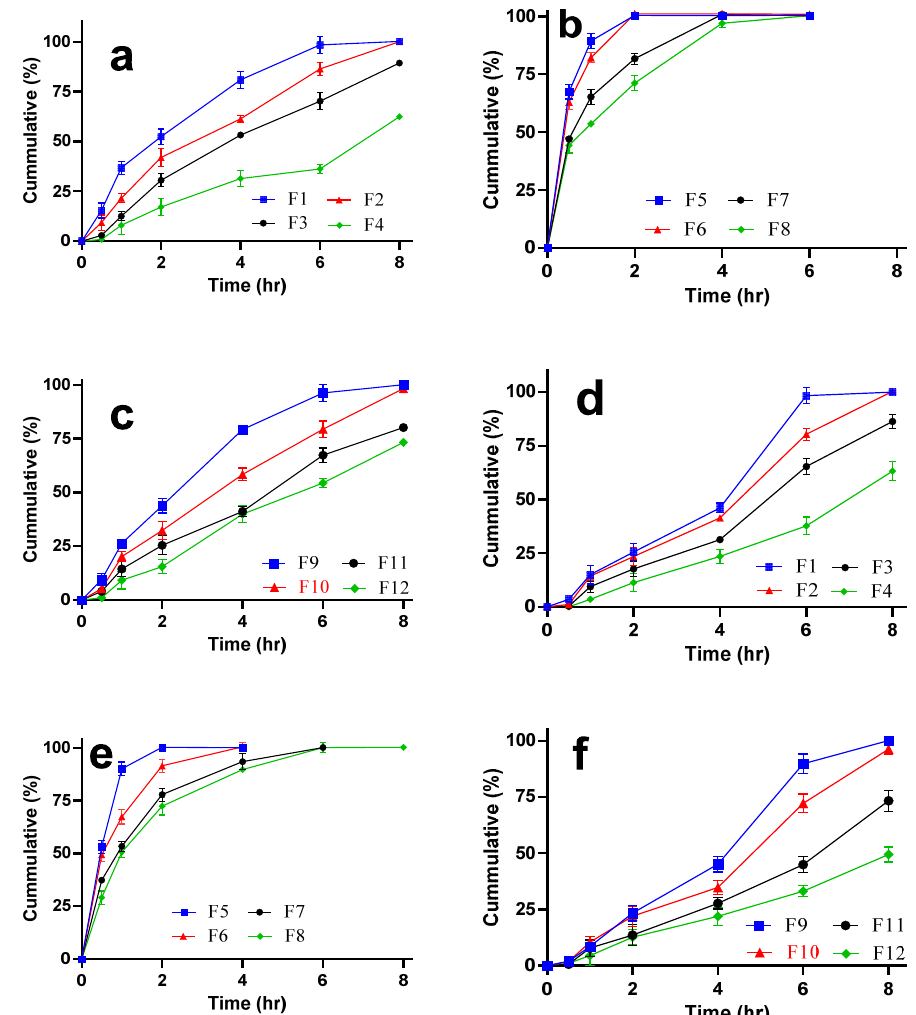
Figure 12. In vitro release of BZN ( a – c ) and TIB ( d – f ).